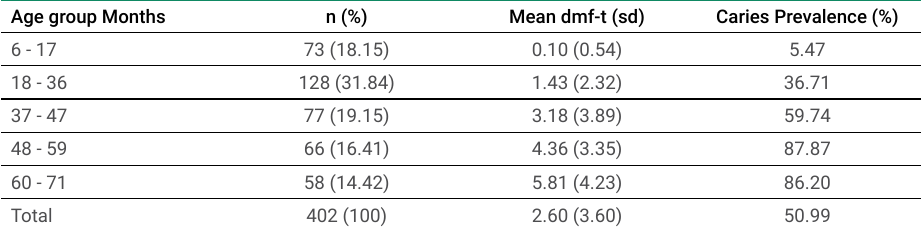
Table 1. Distribution, mean value of dmf-t index, standard deviation and prevalence of dental caries among indigenous children, according to